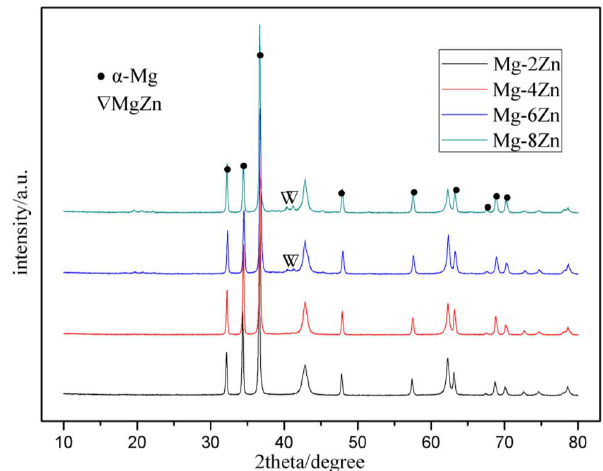
Figure 5. XRD patterns of laser-melted Mg-Zn alloys. Table 2. The diffraction peak intensity of the MgZn phase in Mg-Zn alloys.